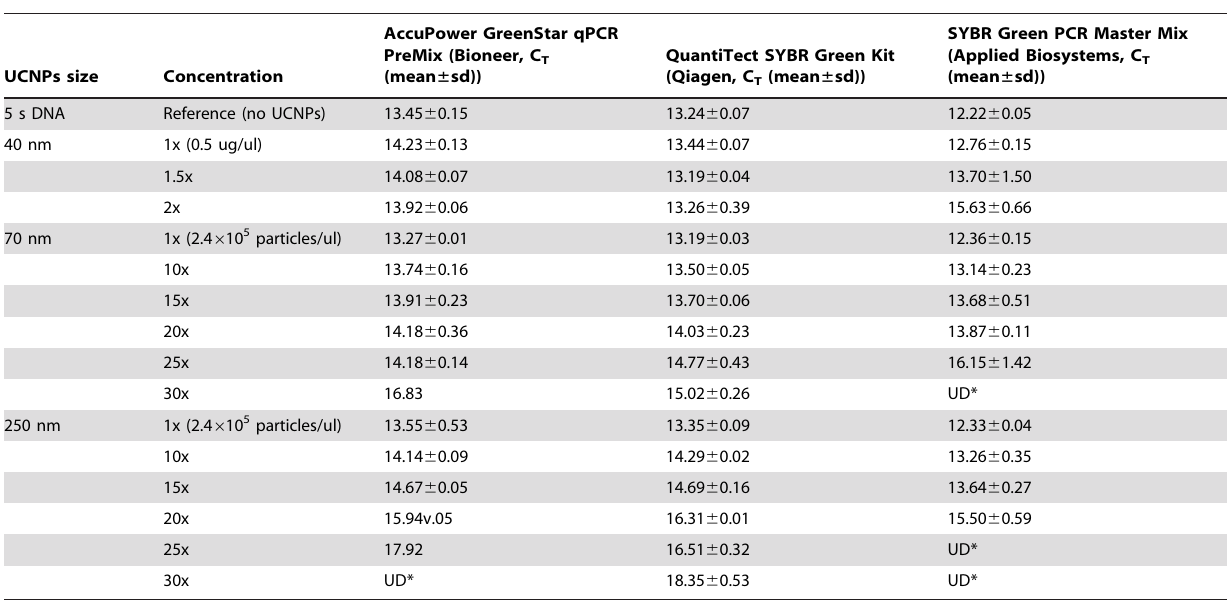
Table 1. Effects of UCNPs on PCR amplification efficiency, using 3 commercial real-time PCR master mixes.